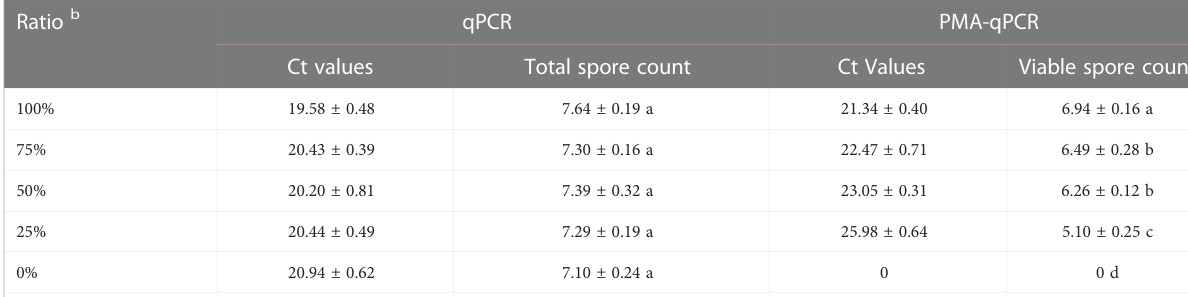
TABLE 1 Comparison of total and viable C. cassiicola spore counts obtained by different methods a